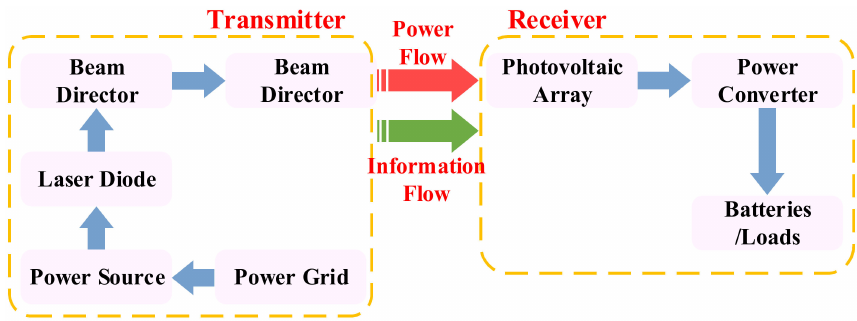
Figure 4. Components and fundamentals of the OWPT